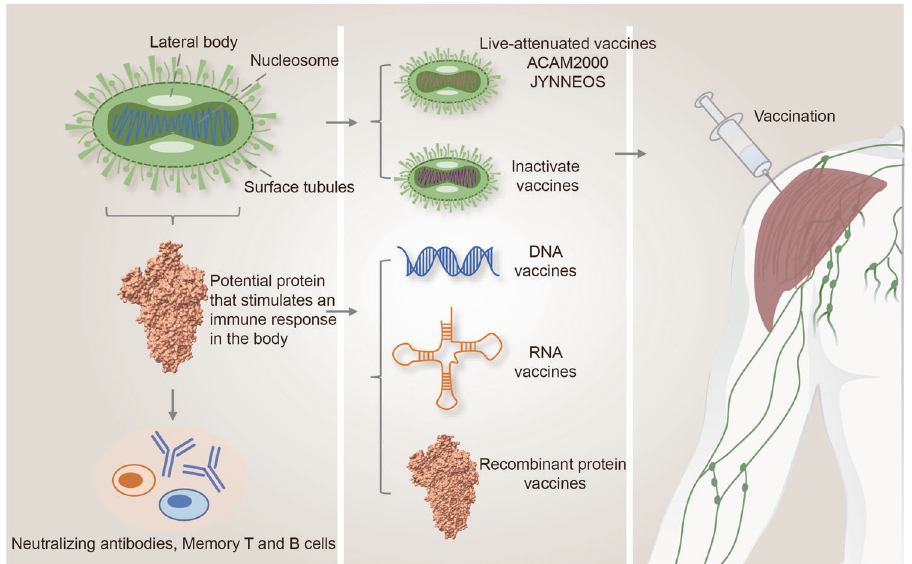
Fig. 4 Development of monkeypox vaccines in the future. Currently, live attenuated vaccines such as ACAM2000 and JYNNEOS are clinically recommended for the prevention of monkeypox, but these vaccines were originally designed to prevent smallpox. Therefore, there is a demand for the development of vaccines that speci fi cally prevent monkeypox, such as inactivated vaccines, DNA vaccines, RNA vaccines, and recombinant protein vaccines. These types of vaccines have proven their ef fi cacy and safety in the COVID-19